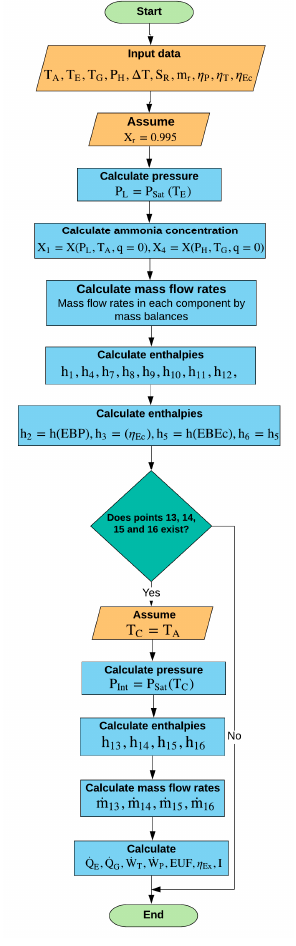
Figure 4. Algorithm flow chart for the modeling of the three cycles.